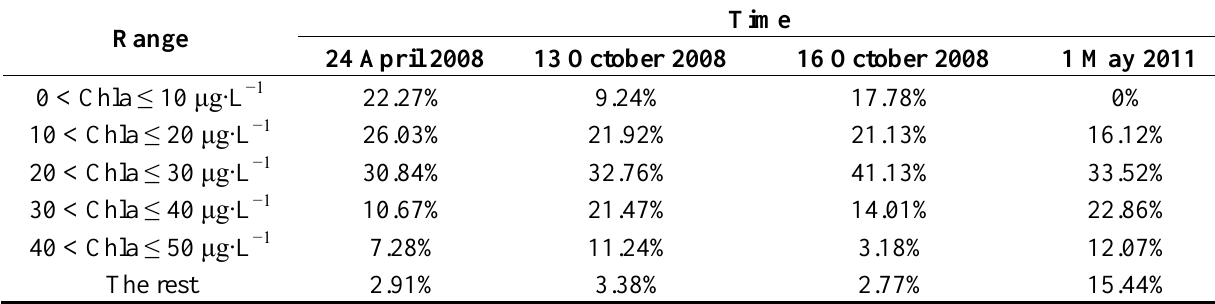
Table 5. Coverage percentage of Chla in MERIS images for Lake